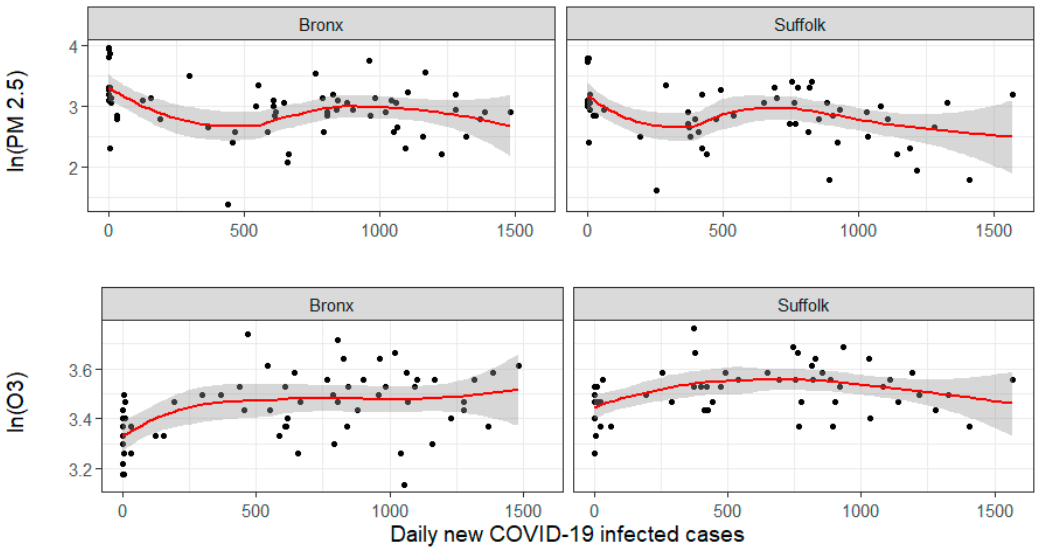
Figure 8. Scatter plots for the number of daily COVID-19 new infected cases vs. logarithmic value of PM 2.5 concentrations (measured in μ g/m 3 ) (upper panel) and logarithmic value of ozone concentrations (measured in mg/m 3 ) (lower panel) for two selected counties Bronx and Suffolk. The red line depicts a Locally weighted scatterplot smoothing (Lowess) for the scattered data plot. Similar plots for all the current study counties are reported in the Appendix A, Figure A4 and A5.